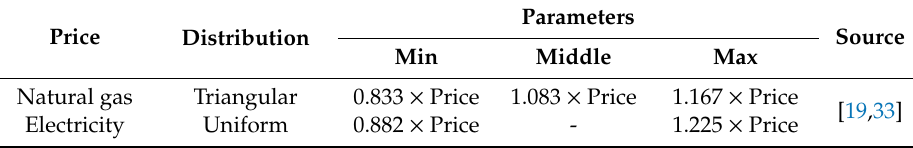
Table A5. The probability distribution of natural gas and electricity